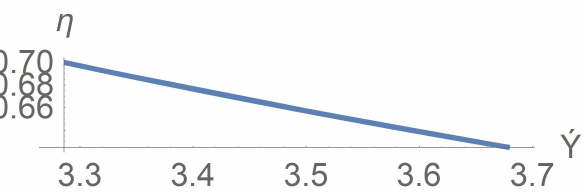
Figure 10. Apparent viscosity η versus velocity gradient ˙ γ for the case Π = Π 0 =